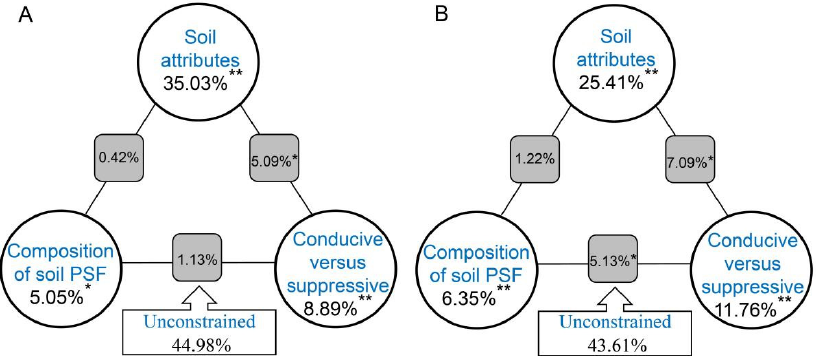
Figure 3. VPA map of the effects of the soil attributes, composition of soil particle-size fraction (PSFs), soil conditions (conducive or suppressive), and the interactions of these factors on the com- munity structure of bacteria ( A ) and fungi ( B ). The soil attributes include the total carbon, total ni- trogen, C/N, and the activities of urease, sucrase, catalase and neutral phosphatase. In the VPA map, “**” indicates a significance of p < 0.01; “*” indicates a significance of p < 0.05, and the percentage of variation explained by interactions between two or three of the factors is indicated as gray squares and circles on the sides.